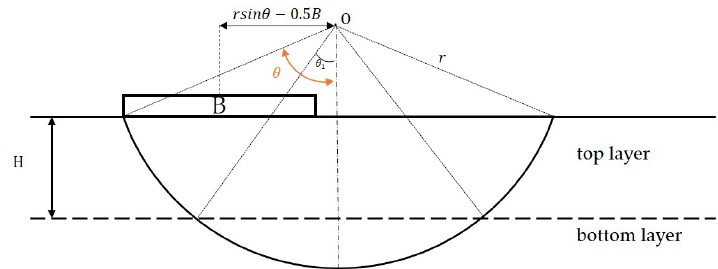
Figure 3. Sketch of failure surface of two-layered slip circle method (modified from